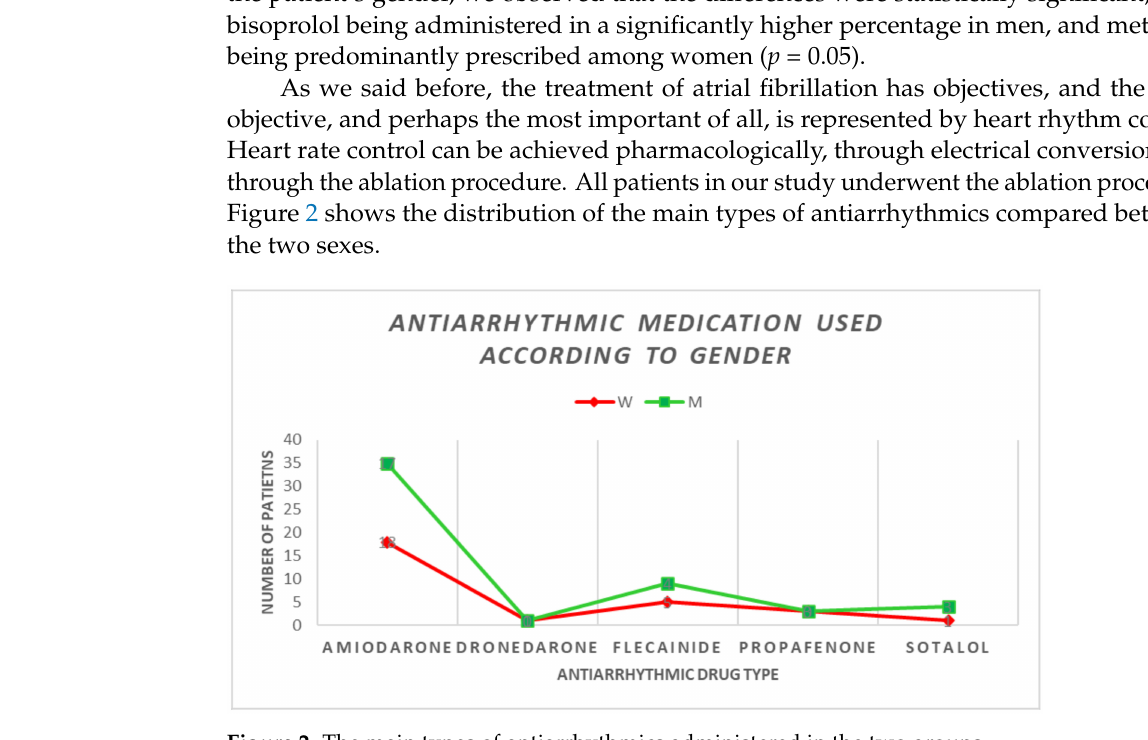
Figure 2. The main types of antiarrhythmics administered in the two